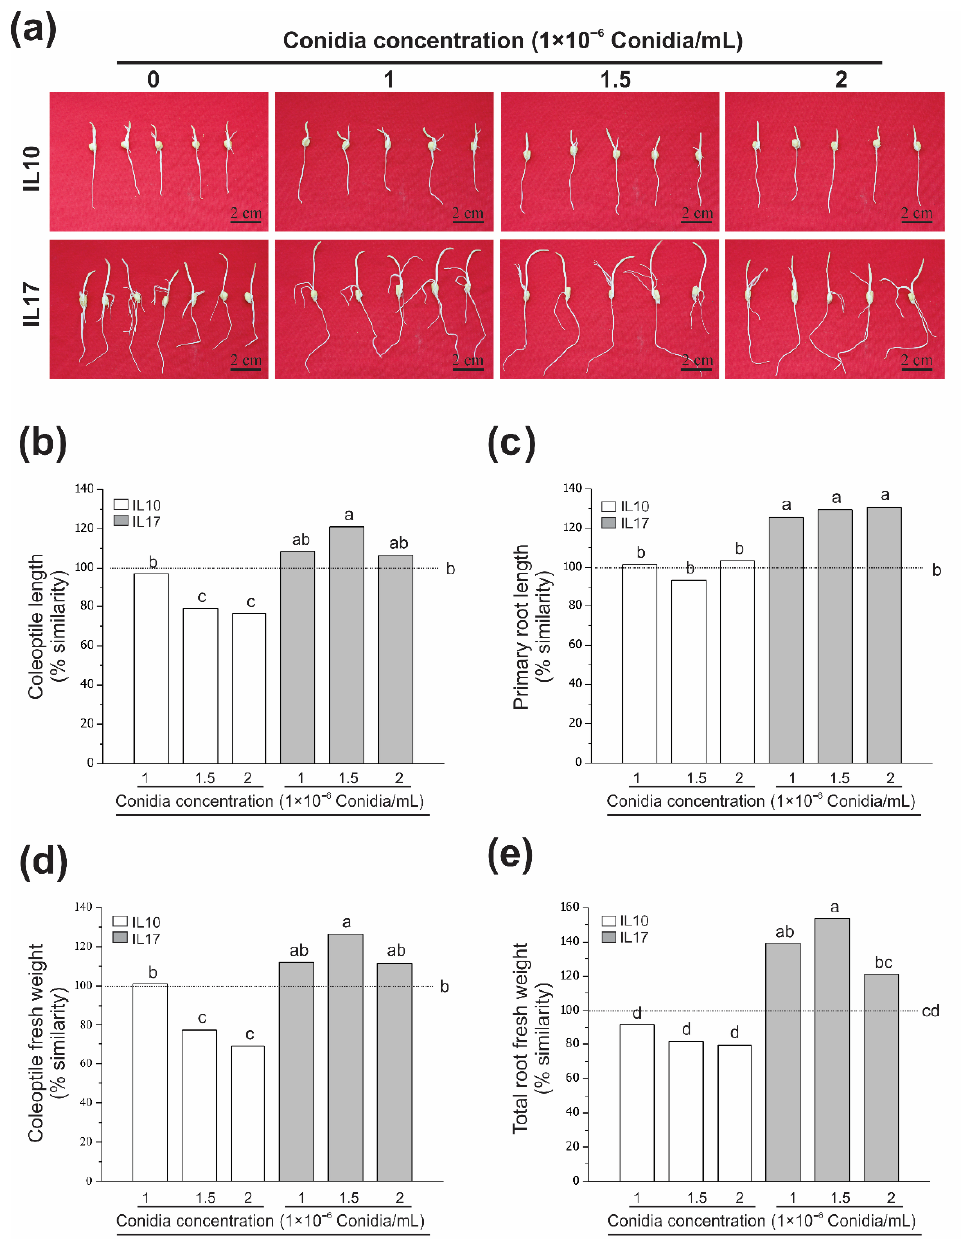
Figure 1. Fusarium effect on the post-germination of maize emergence (VE stage). ( a ) Lines IL17 and IL10 non-infected and infected with Fusarium verticillioides at four days post-inoculation. Seedlings were infected with different F. verticillioides conidia concentrations: 0, 1, 1.5 or 2 (1 × 10 − 6 conidia/mL). Data for ( b ) coleoptile length, ( c ) primary root length, ( d ) coleoptile fresh weight, and ( e ) root fresh weight were collected and analyzed for their similarity to the control plants (without infection). The different letters above the bars refer to significant differences using the Duncan means test ( α = 0.01; n = 15). The dashed line at 100% represents the control value. The experiments were performed three times with a completely randomized design.